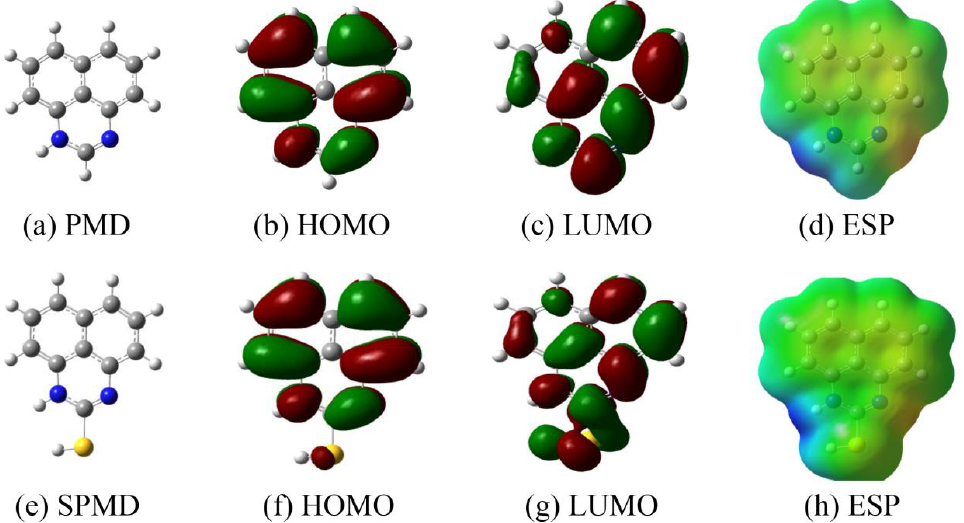
Figure 8. Structures of HOMO, LUMO and ESP of perimidine derivatives.